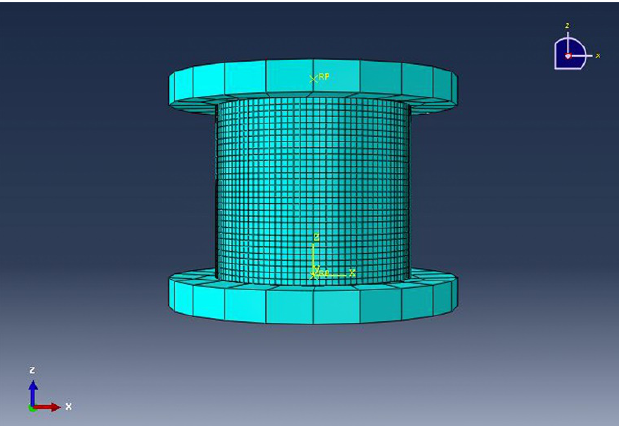
Figure 7. The mesh model of the 3D woven composites with tubular.